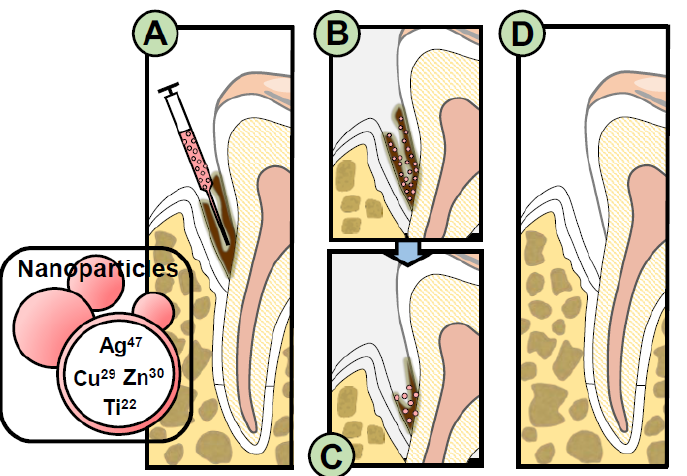
Figure 3. Illustration for the treatment of periodontitis with nanoparticles containing anti-biofilm molecules ( A ) Delivery of anti-biofilm nanoparticles into diseased sites; ( B ) ability of nanoparticles to attach to and incorporate into biofilm and release active agents such as CHX for up to 48 h; ( C ) gradual reduction of multispecies biofilm; ( D ) elimination of biofilm and established state of health. A similar therapeutic approach could be used for the treatment of peri-implantitis.